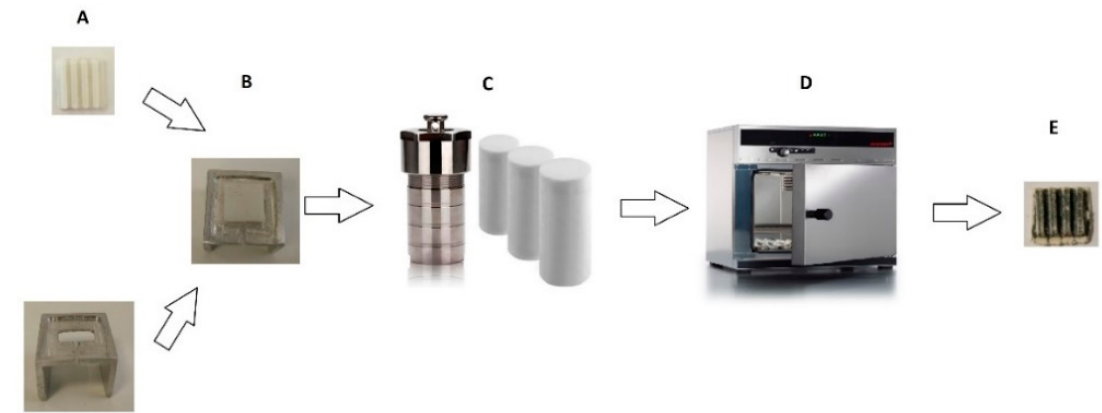
Figure 2. Illustration of nanostructured ZnO synthesis steps onto 3D-printed substrate. ( A ) 3D-printed polylactic acid (PLA) substrate; ( B ) Metal base with substrate on top; ( C ) Stainless steel (ss) autoclaves; ( D ) Oven at 200 °C for 2 h; E. Final ZnO-coated PLA 3D-printed scaffolds.